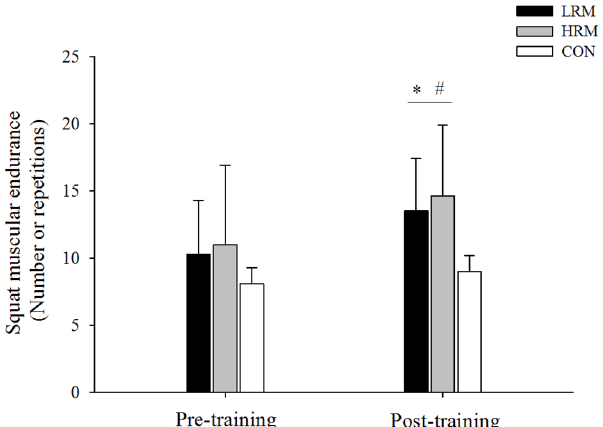
Fig 4. Mean ± SD of squat muscular endurance pre and post 9 week of resistance training. LRM, heavy load – low repetition maximum resistance training group. HRM, moderate load – high repetition maximum resistance training group. CON, control group. ( * ) p < 0.05, higher than pre training. (#) p < 0.05, higher than CON